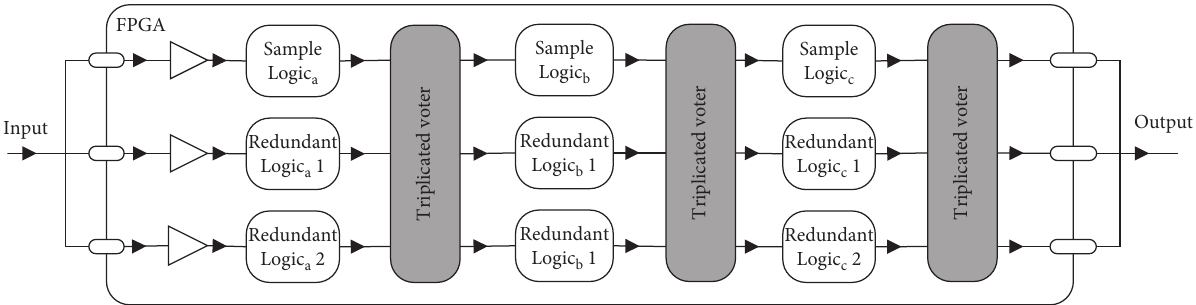
Figure 1: TMR implementation in